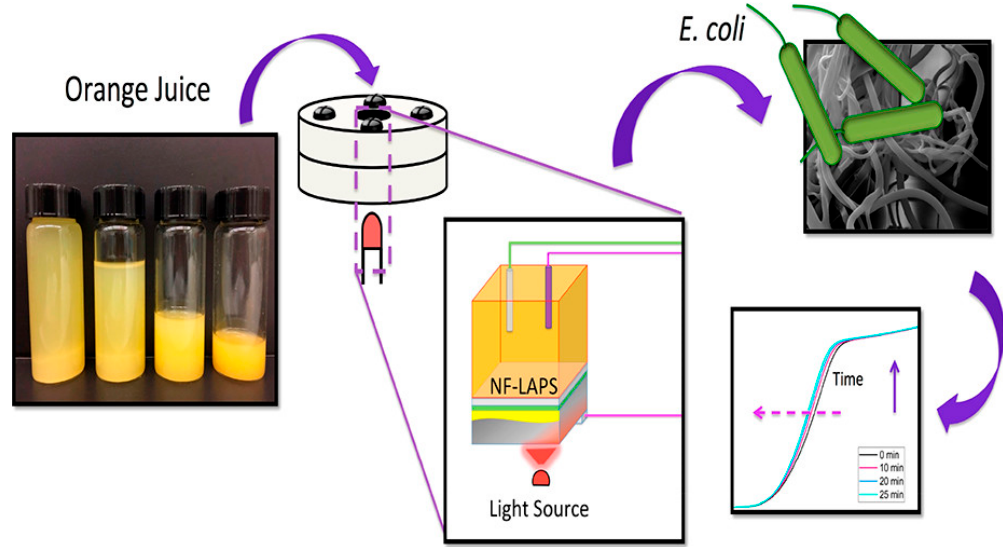
Figure 7. Schematic illustration of the nanofiber-light addressable potentiometric sensor (NF-LAPS) sensor comprising a three-electrode system [86]